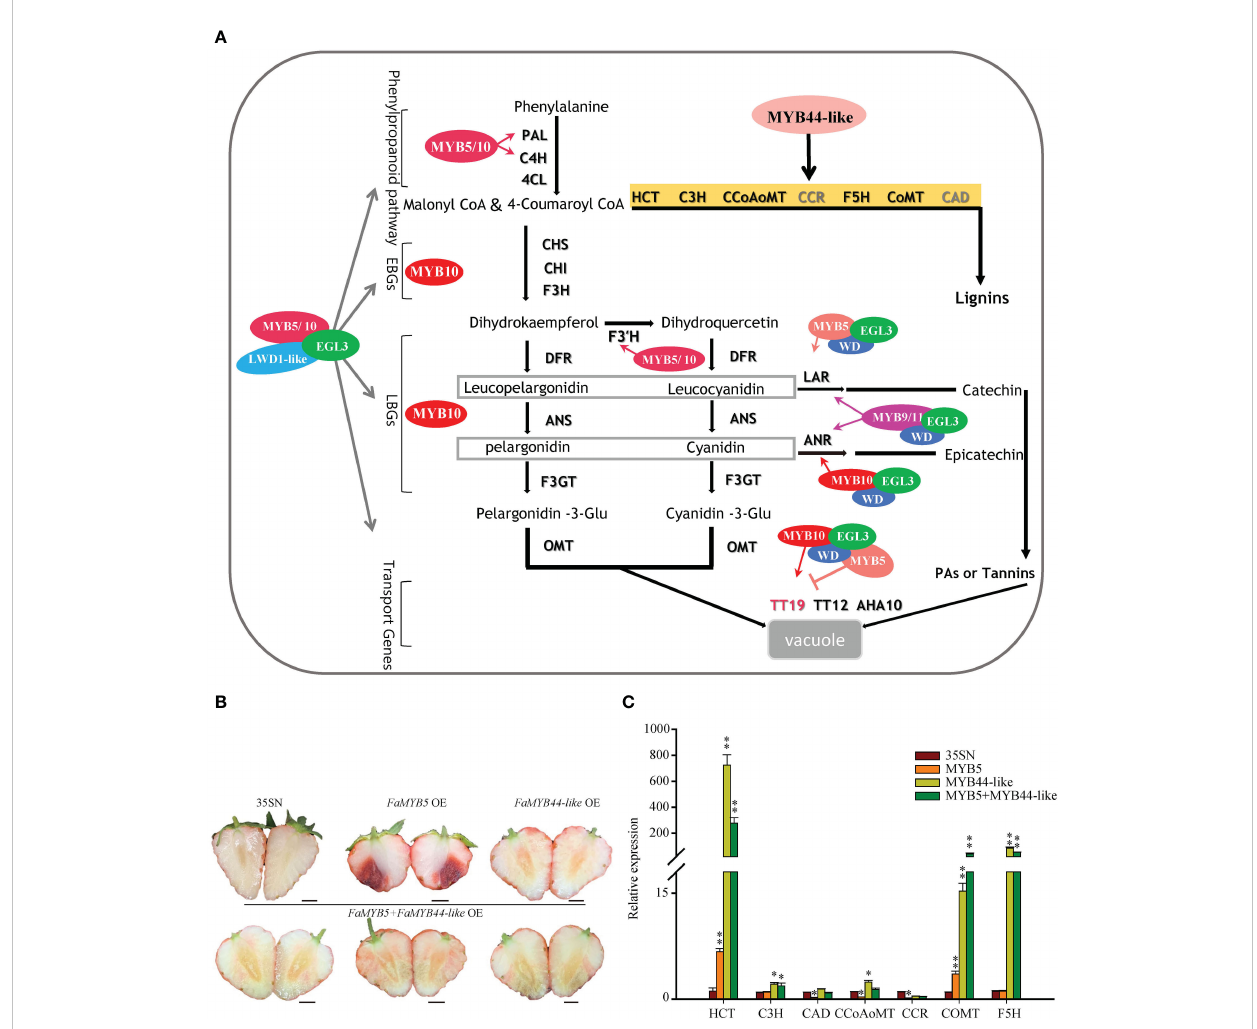
FIGURE 6 Regulation of fl avonoids by MYBs and MBW complexes. (A) A proposed model for distinct regulation patterns of fl avonoids by different MBW complexes in strawberry fruits. (B) The phenotype of co-overexpressed FaMYB5 and FaMYB44-like in ‘ Xiaobai ’ . 35SN (empty vector) was as control, Scale bars represent 10 mm. (C) qRT-PCR analysis of relative expression levels of key structural genes of lignin metabolic pathway. Error bars are SEs for three replicates, statistical signi fi cance was determined by Student ’ s t-test (**, P < 0.01; *, P <